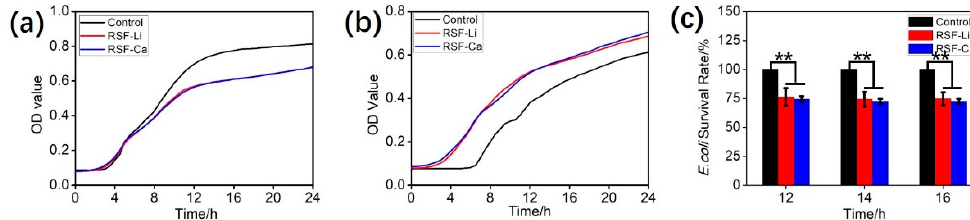
Figure 4. Antibacterial properties of the RSF-Li and RSF-Ca. Growth curves of ( a ) E. coli and ( b ) S. aureus . ( c ) E. coli survival upon incubation with RSF at the following time points: 12, 14 and 16 h (** p < 0.01, n =